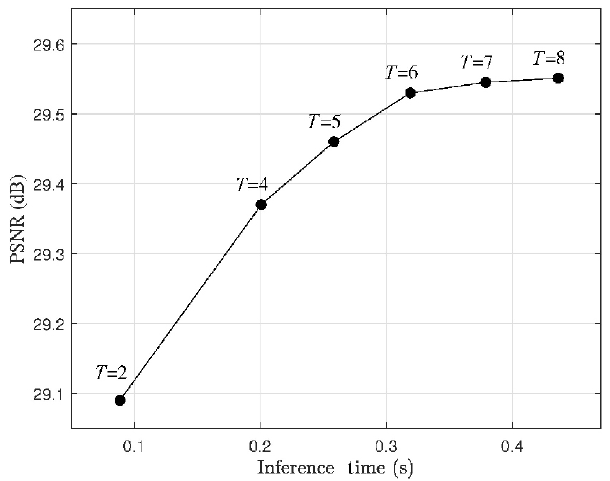
Fig. 10 Varying the number T of FDMs. PSNR (dB) results for color image denoising are evaluated on the Urban100 dataset with noise level σ = 50.